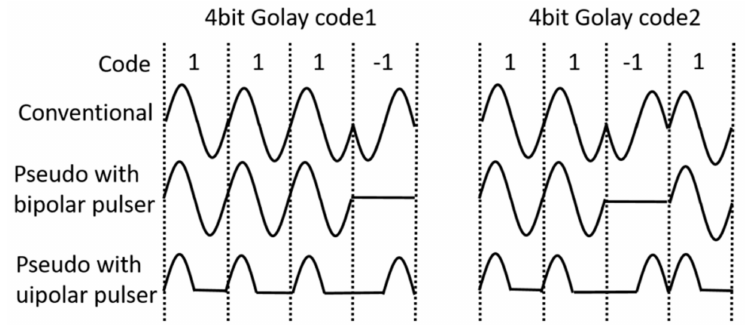
Figure 2. Comparison of waveforms of the conventional, pseudo Golay code with bipolar and unipolar pulses.